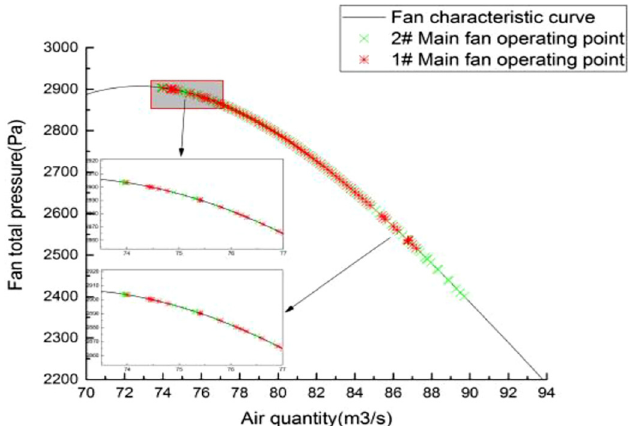
Fig. 12. Variation of operating points of two main fans during switchover